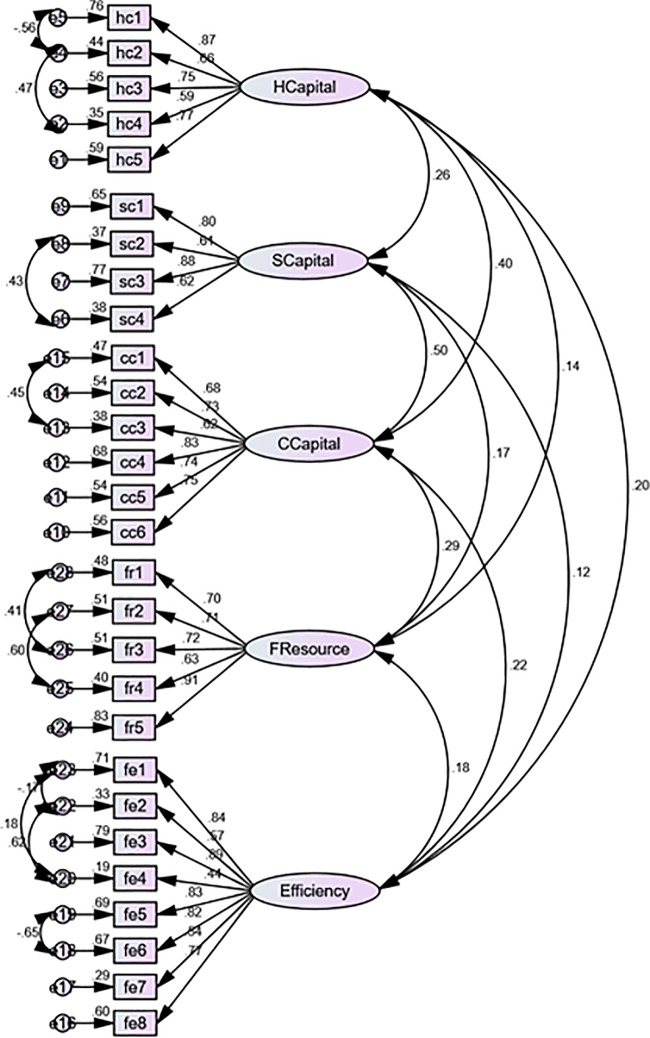
Measurement model.